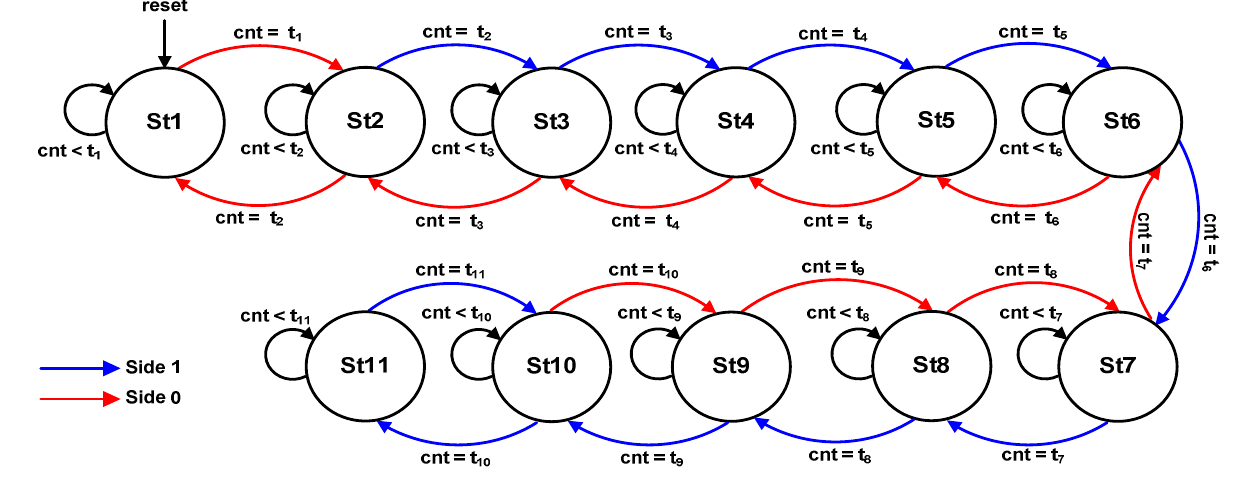
Figure 8. State diagram of the SHE digital switching controller.